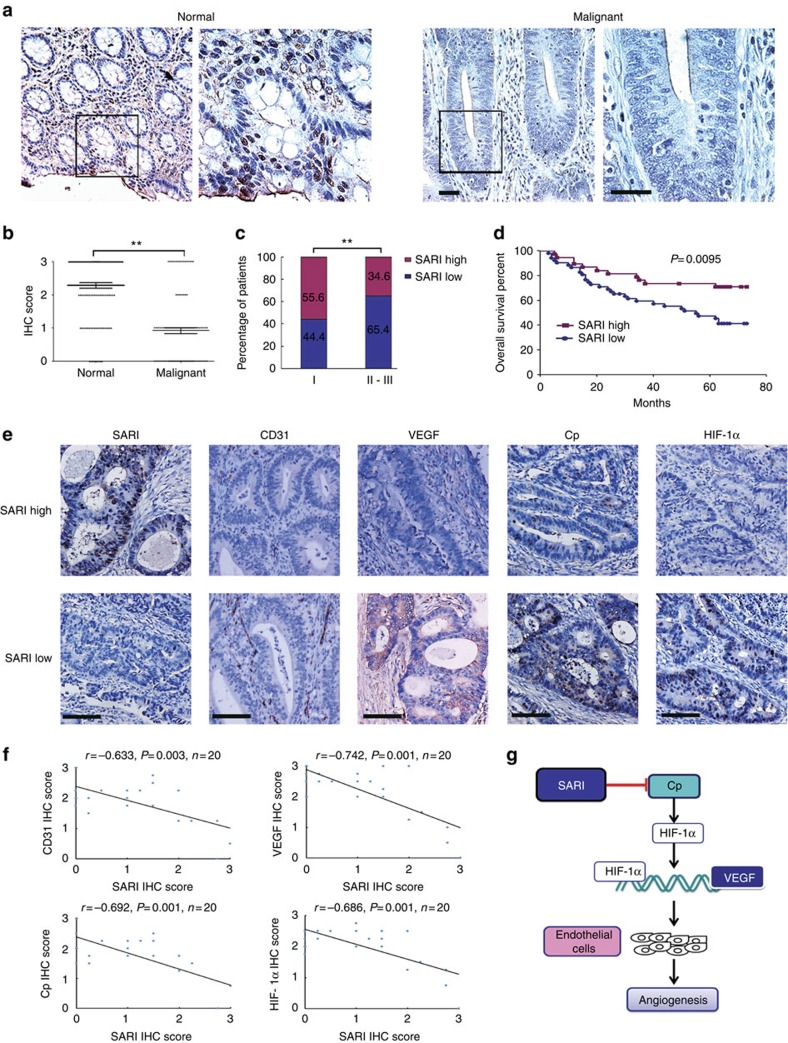
Validation of SARI in human colon cancer tissue microarray.(a) Analysis of tissue microarrays (TMAs). Staining for SARI on TMAs containing 135 normal and malignant colon tissues. Scale bar, 100 μm. (b) Statistical analysis was performed using the GraphPad Prism 5 program to compare the relative levels of SARI between normal and malignant colon tissues (Mann–Whitney test; n=135; **P<0.01; Student's t-test). Black triangles indicate the colon sample, and the transverse lines indicate the mean. (c) Percentage of patients with high and low expression of SARI according to tumour differentiation stage. Numbers in bars represent the percentage of patients. (n=90; **P<0.01; Student's t-test). (d) Kaplan–Meier curve showing overall survival of patients (in percentage) with colon cancer, stratified by SARI expression (high- and low-scoring tumours). SARI expression was determined by immunohistochemistry staining and scored as described in methods. The log-rank test was used to compare differences between groups (n=90; P=0.0095; long-rank test). (e,f) Correlation analyses of SARI, VEGF, Cp and CD31 in of human malignant colon tissues from 20 patients. SARI, VEGF, CD31, Cp and HIF-1α expression levels were determined by immunohistochemistry staining and scored as described in methods (e). Scale bar, 100 μm. Pearson's correlation coefficient (r) and P value are shown (f; n=20; Pearson analysis). (g) Model for angiogenesis inhibition by SARI through direct targeting of Cp and subsequent inactivation of the HIF-1α/VEGF axis.